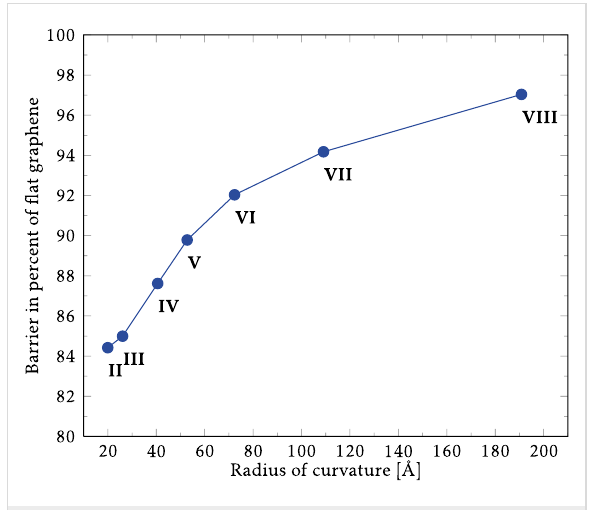
Figure 2: Calculated reaction barriers for hydrogenation of bent graphene as a function of the local radius of curvature (II–VIII in Figure 1a). Flat graphene (position I) has an infinite radius of curva- ture and is used to normalise the barriers. Calculations are spin- polarised and allow for atomic relaxation.